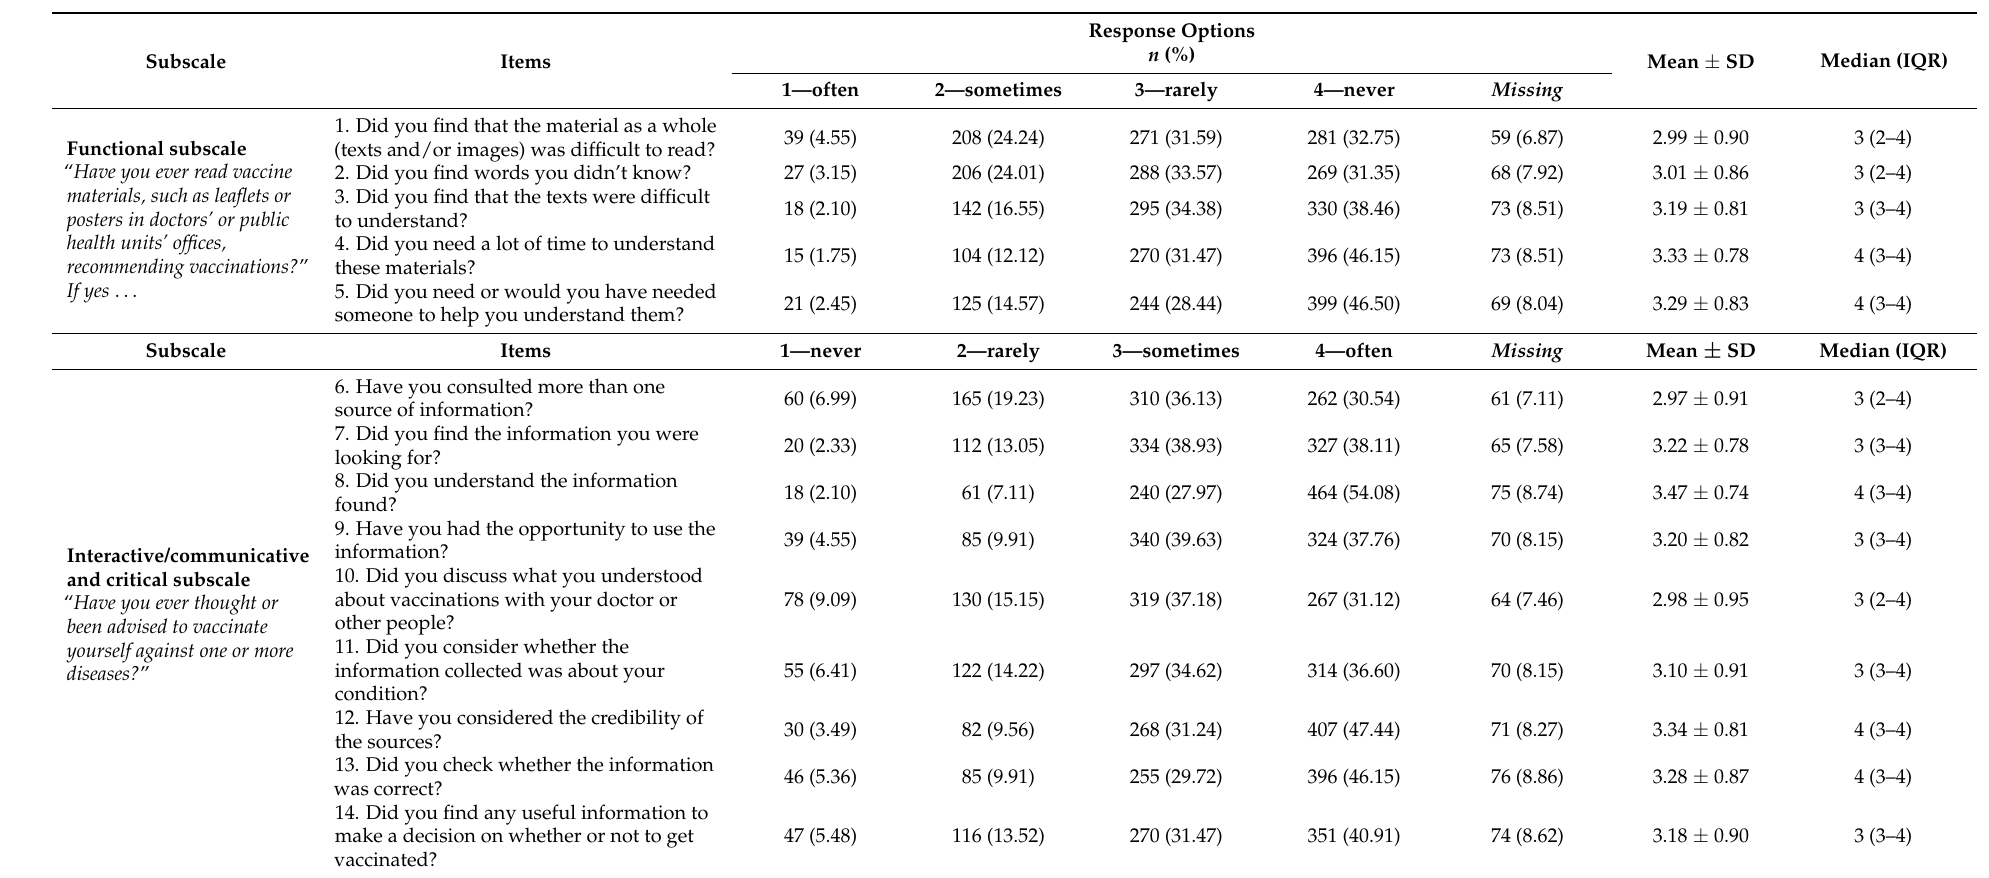
Table 4. HLVa-IT: item